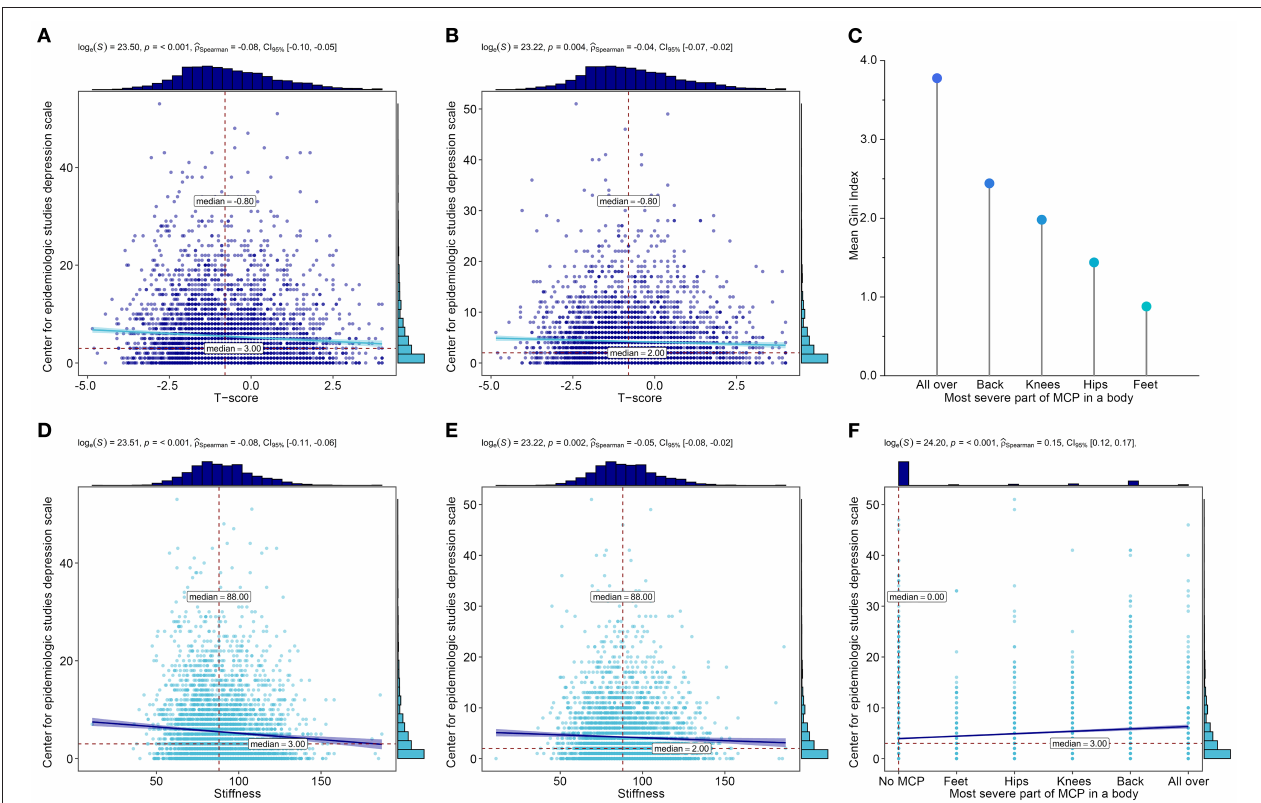
FIGURE 3 | Further analyses for osteoporosis and MCP. (A) Association between T -score and depressive symptoms at baseline . (B) Association between T -score and depressive symptoms at Wave 2. (C) Mean Gini Index quantified the contributions of different body parts with the most severe MCP. (D) Association between stiffness and depressive symptoms at baseline. (E) Association between stiffness and depressive symptoms at Wave 2. (F) Association between the most severe body part of MCP and depressive symptoms at Wave 2.